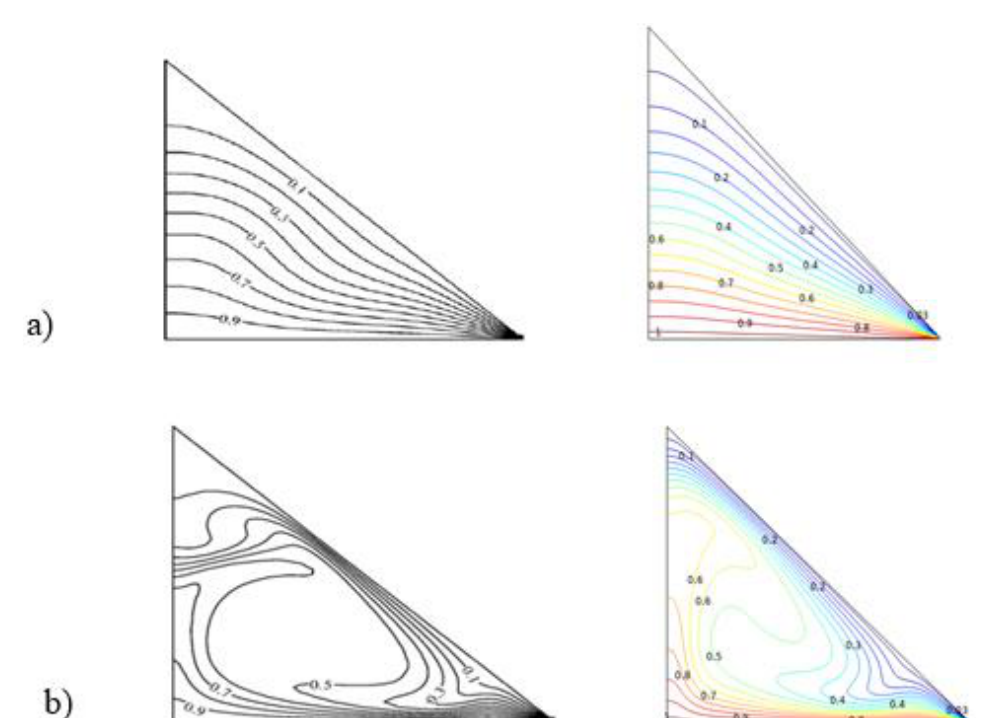
Figure 3. Isotherm and streamline comparison: previous work (left) and current work (right) for Ha = 0 ( a ), Ra = 10 4 ( b ), and Ra = 10 6 .